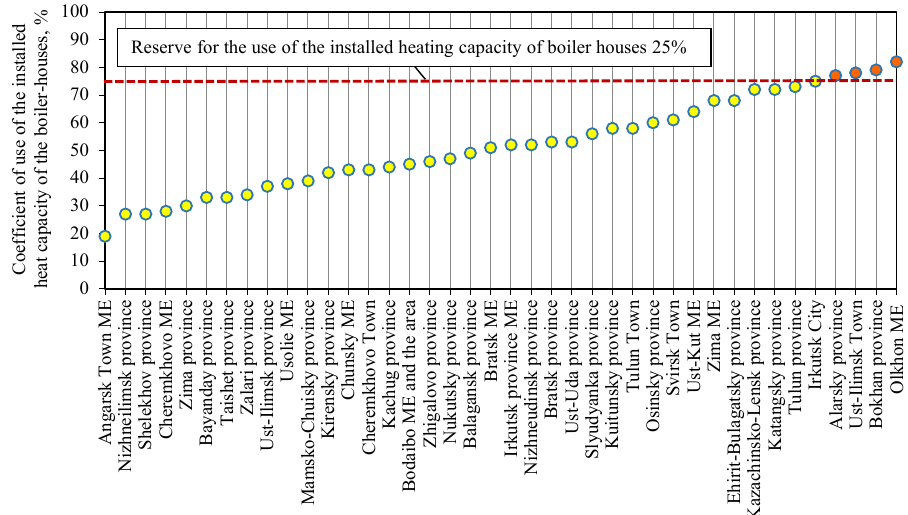
Fig. 4. Efficiency of boiler capacity use in MU of the Irkutsk